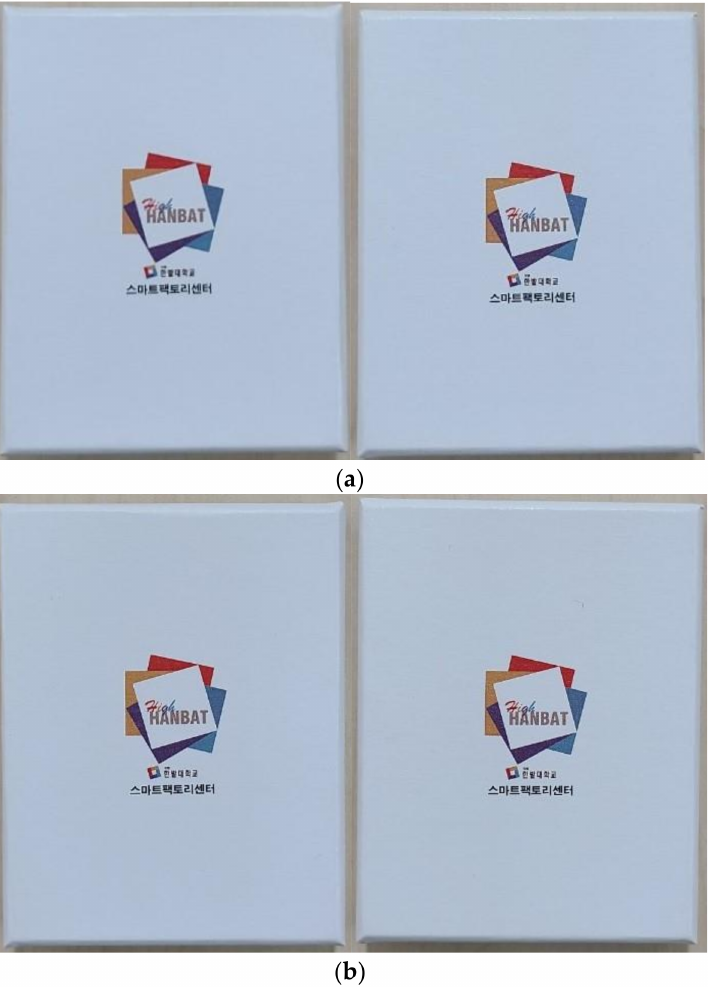
Figure 5. Target objects: ( a ) two samples of box type I; ( b ) two samples of box type II. (They do not show any significant difference in 2D